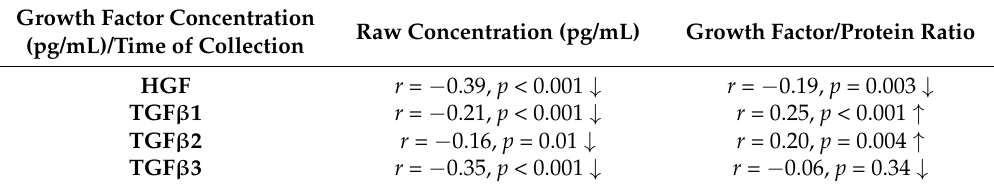
Table A2. Absolute and relative decline of growth factors over